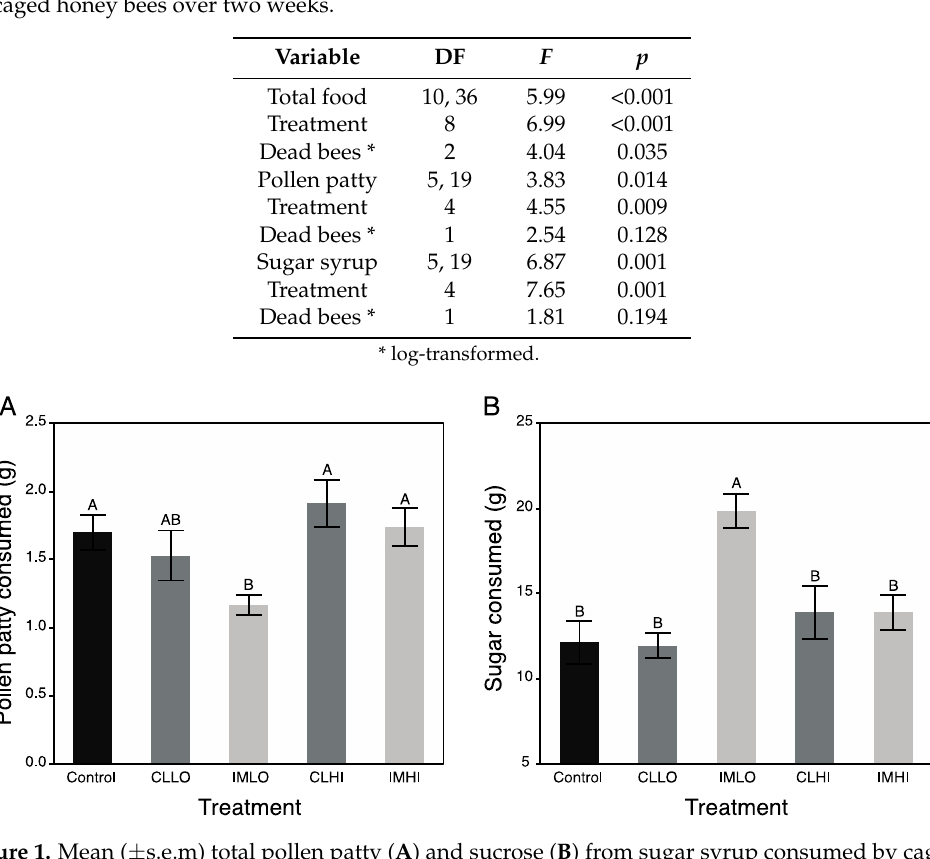
Figure 1. Mean ( ± s.e.m) total pollen patty ( A ) and sucrose ( B ) from sugar syrup consumed by caged honey bees over two weeks. Black bar = Control treatment; Dark grey bars = Clothianidin Low (CLLO) and High (CLHI) dose treatments; Light grey bars = Imidacloprid Low (IMLO) and High (IMHI) dose treatments. Letters above bars represent significant differences across treatments from Student’s post hoc tests.